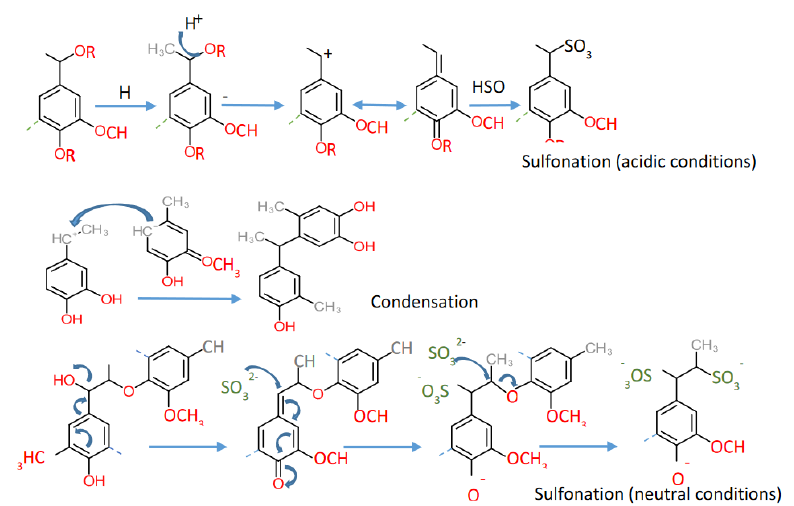
Figure 8. Reactions occurring during Lignosulfonate production [124].